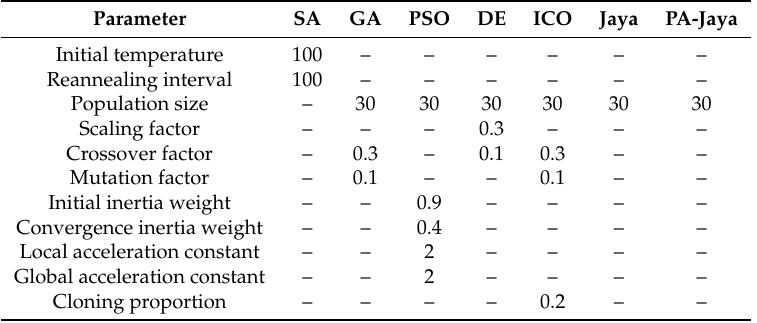
Table 2. Controlled parameters of PA-Jaya and other comparative algorithms.